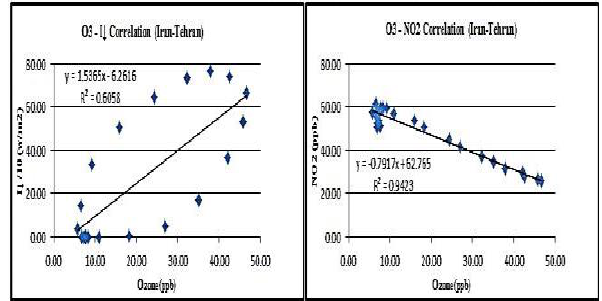
Figure 11- Ozone correlation with downward flux (left) and nitrogen dioxide (right) (Fath pollution monitoring station) To investigate the relationship between temperature and